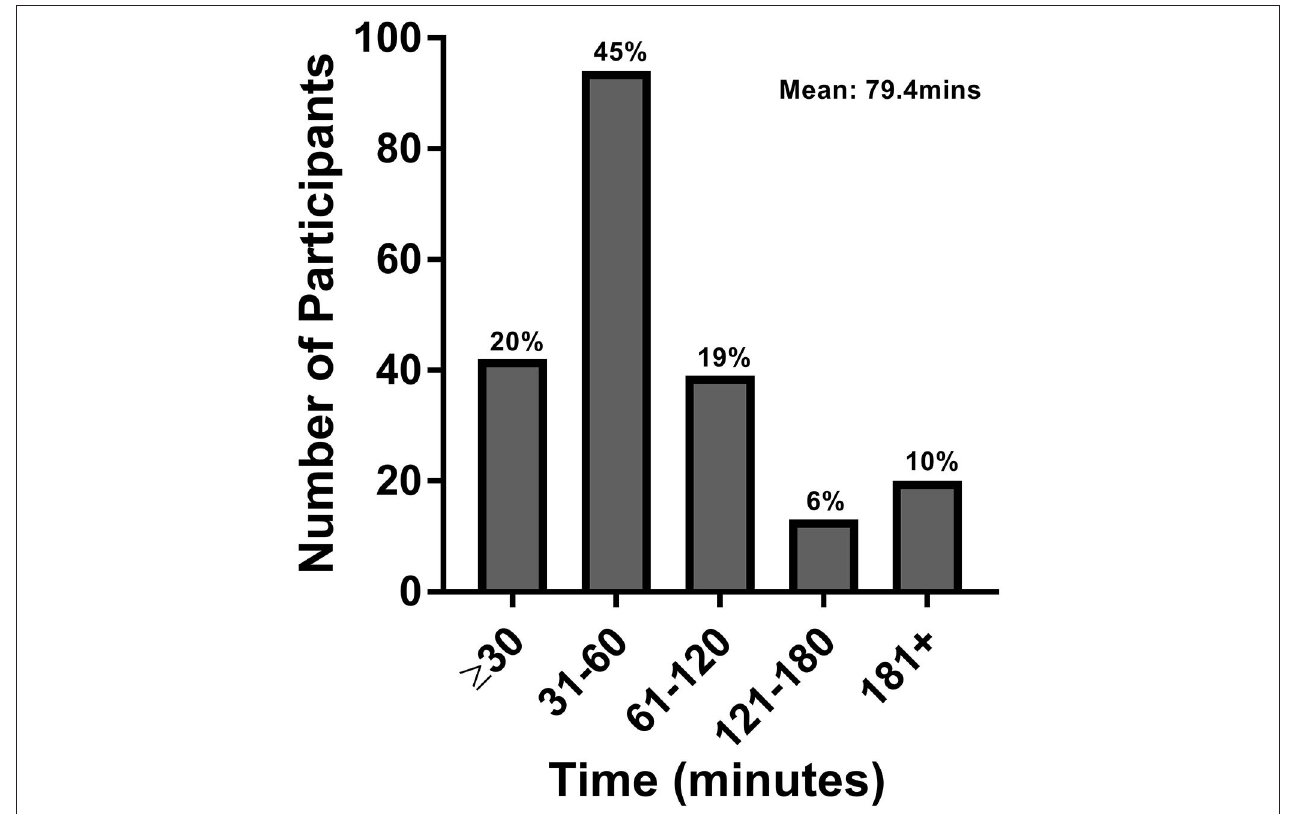
FIGURE 2 | Patient commute time. This figure represents the total roundtrip commute time in minutes for patients